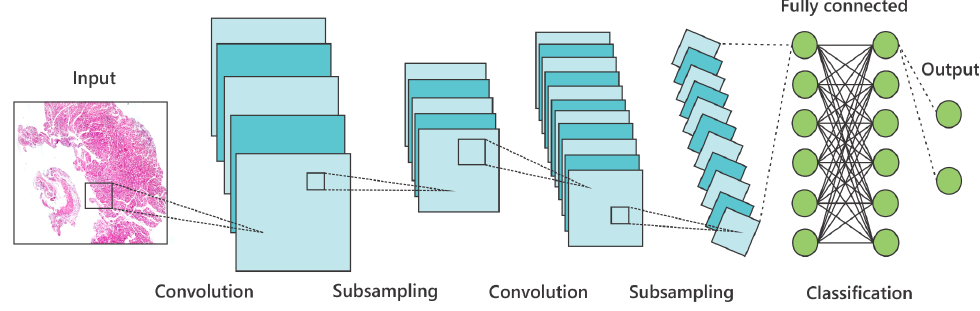
Figure 4. Architecture schema of a standard Convolution Neural